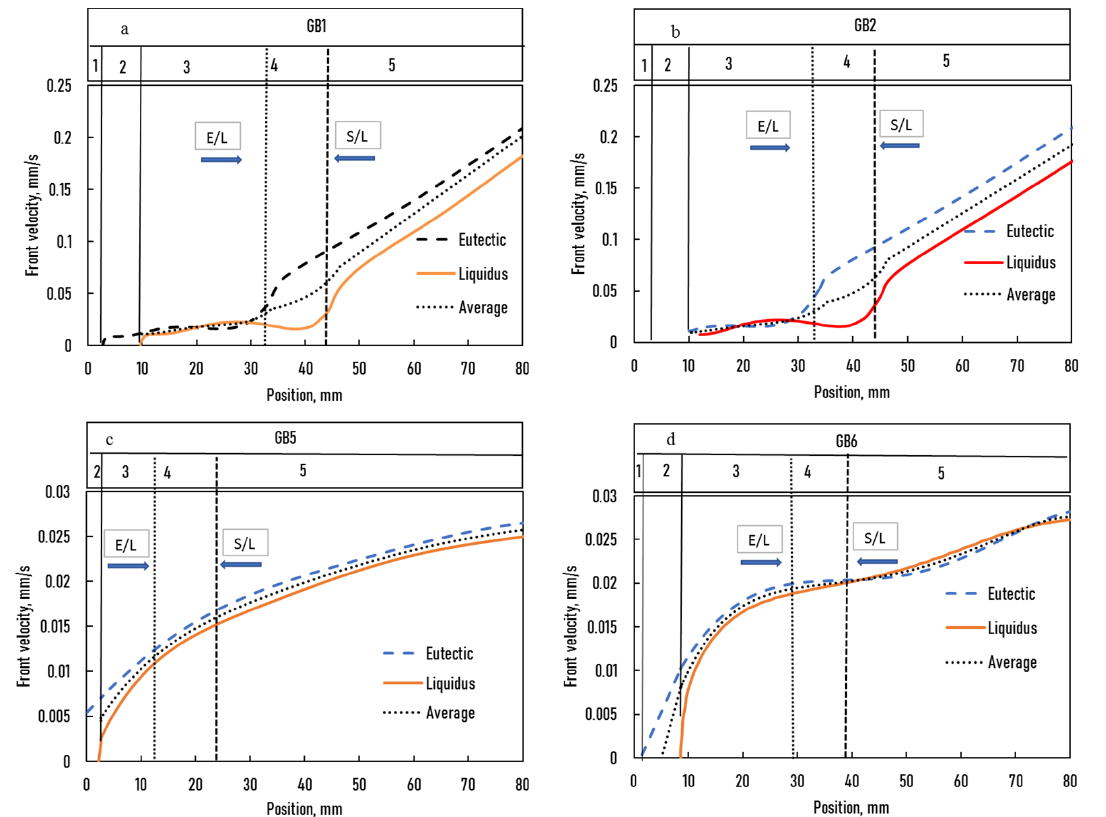
Figure 4. Velocities of the S/L and E/L fronts vs. position for the four ground samples ( a ): GB1, ( b ): GB2, ( c ): GB5, ( d ): GB6.